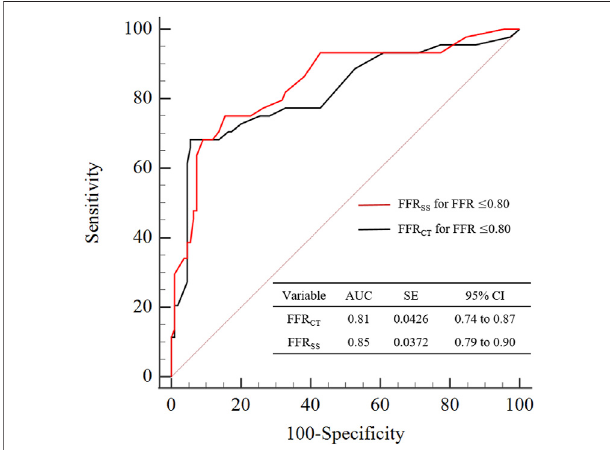
FIGURE 5 | Graphs show diagnostic performance of FFR SS and FFR CT . The diagnostic performance of FFR SS and FFR CT was compared with clinical FFR ≤ 0.80 as the criterion for the diagnosis of myocardial ischemia. It can be seen from the fi gure that the diagnostic performance of FFR SS and FFR CT is comparable, both have good diagnostic performance, and the variance is also close. AUC = area under receiver operating characteristics